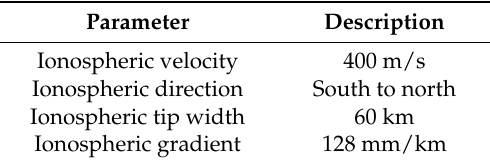
Table 3. Ionospheric anomaly simulation parameters.